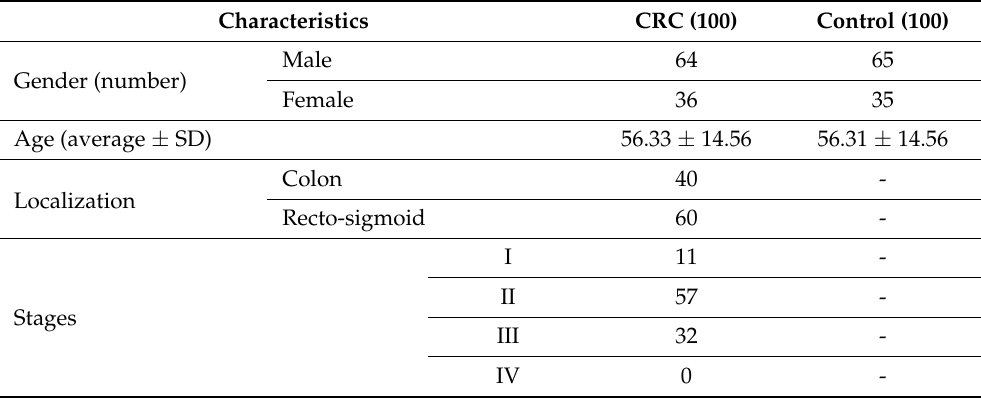
Table 1. Demographic and main clinical data of CRC patients and controls used for PD-1 SNP genotyping.